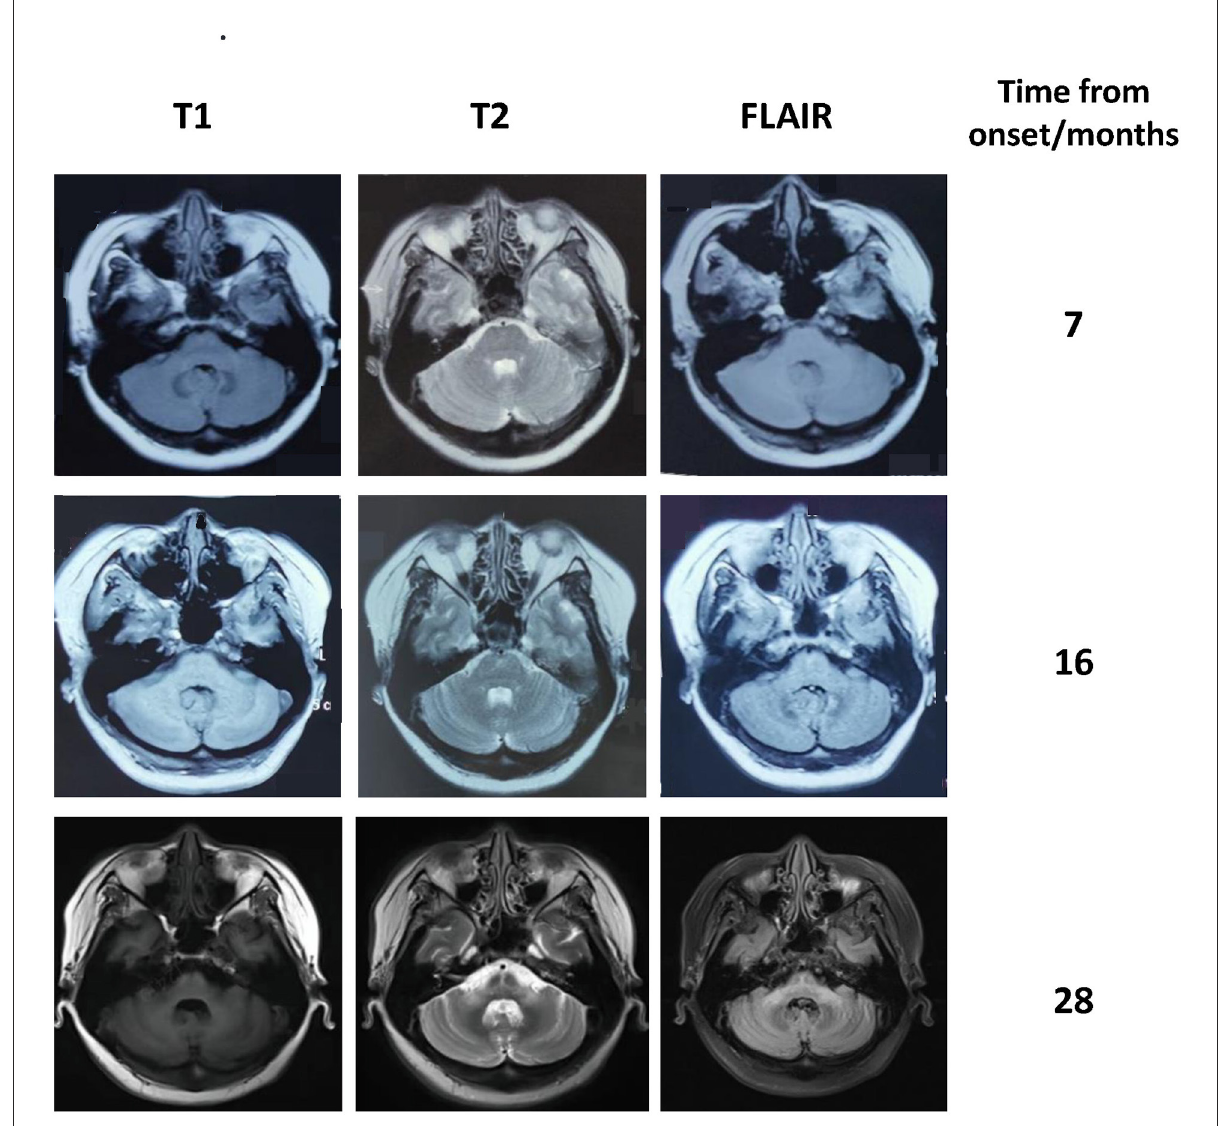
FIGURE1 Brain MRI of our patient showing progressive atrophy of the cerebellum and the middle cerebellar peduncle. The hot cross bun sign and the abnormal signal in the middle cerebellar peduncles became more pronounced over time.